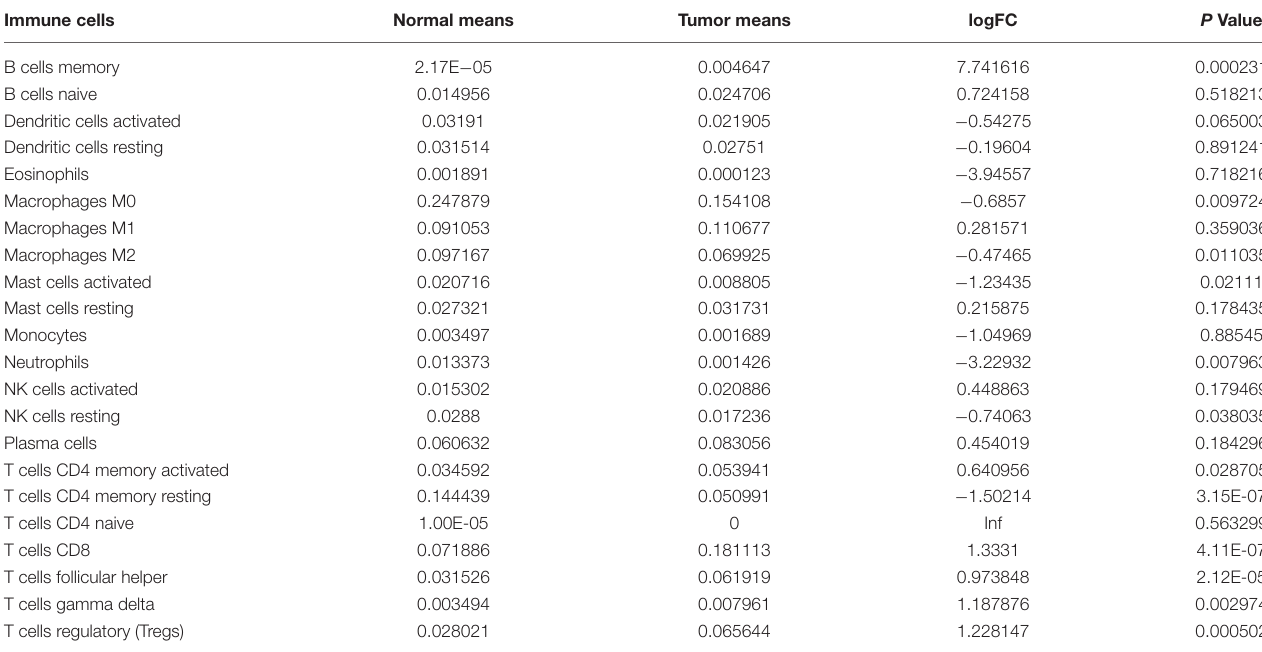
TABLE 2 | Comparison of CIBERSORT immune fractions between HNC HPV positive patients and negative patients. Immune cells Normal means Tumor